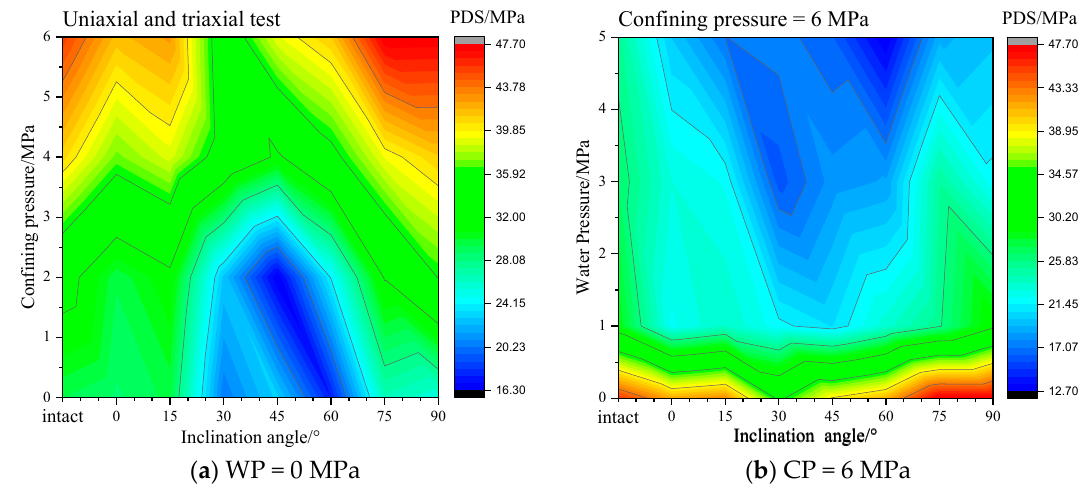
Figure 7. Spatial fitting diagram of peak deviator stress. ( a ) Uniaxial and triaxial compression test; ( b ) hydraulic coupled triaxial compression test under 6 MPa confining pressure.